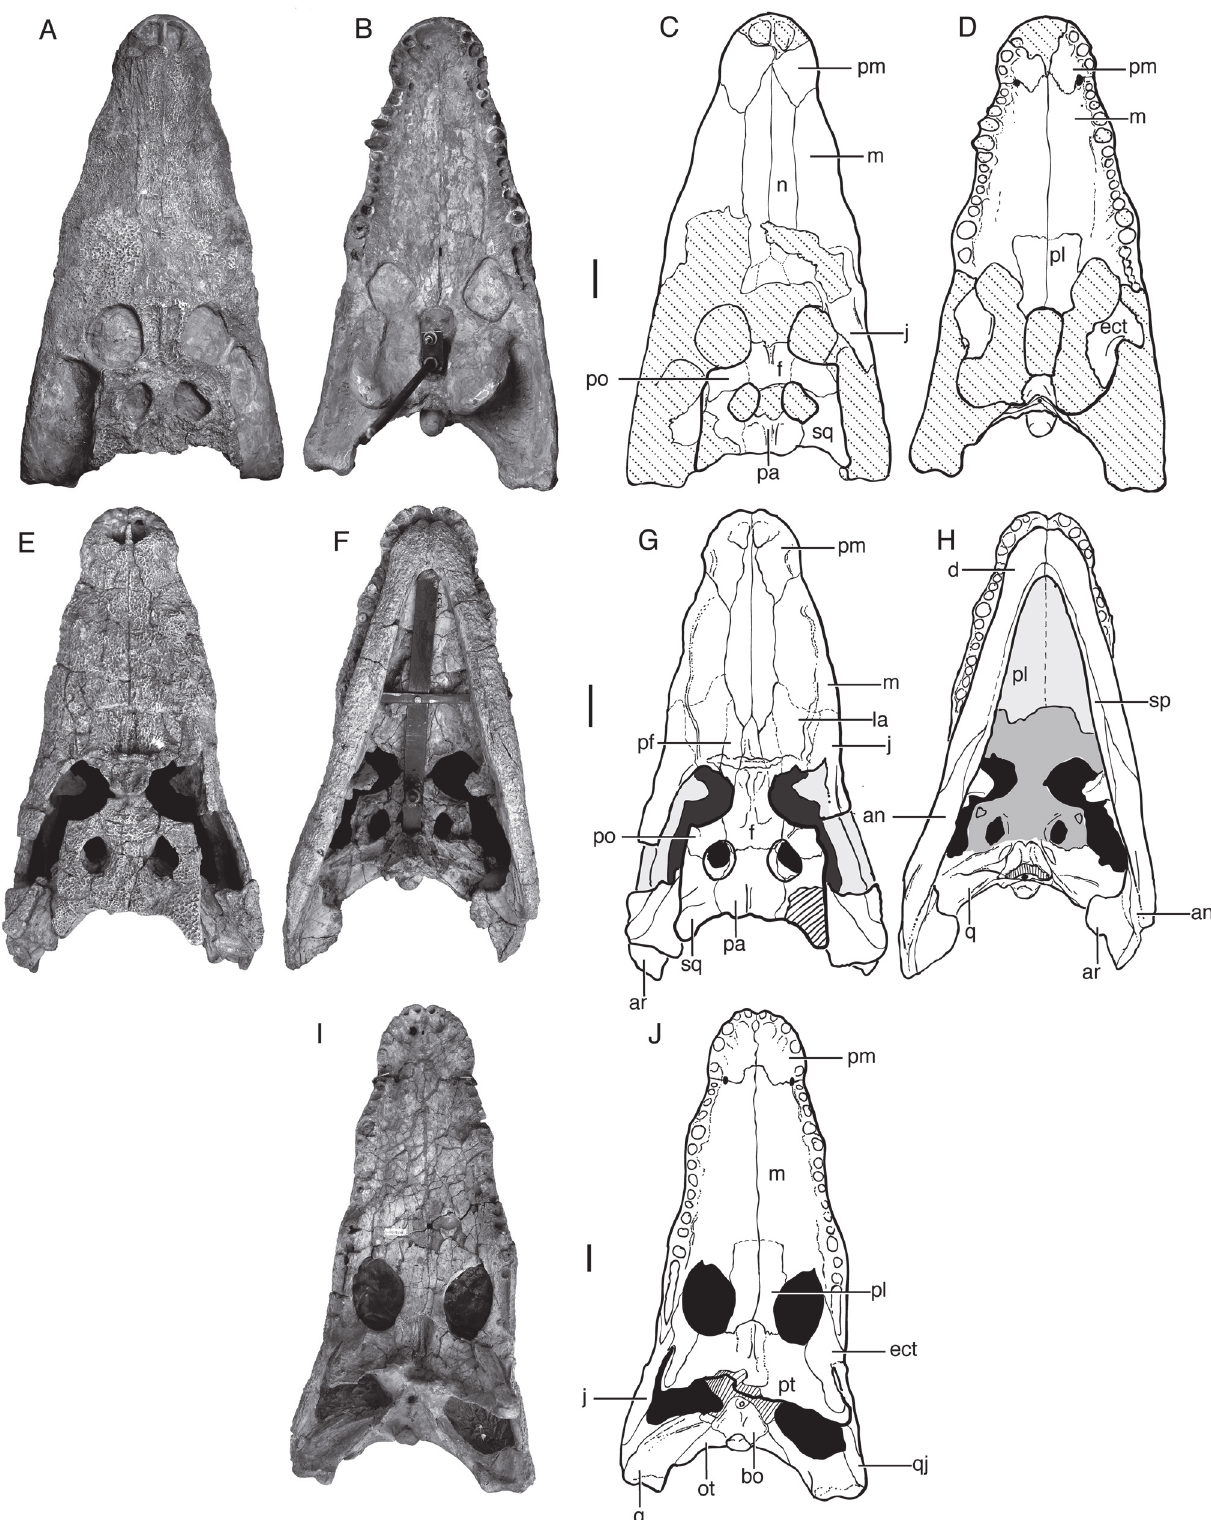
Fig 5. Paralligatorids from Bayanshiree Fm, Cenomanian to Santonian. A , Shamosuchus (= Paralligator ) major (PIN 3726/501, holotype), dorsal view; B , PIN 3726/501, ventral view; C , line drawing of PIN 3726/501, dorsal view; D , line drawing of PIN 3726/501, ventral view; E , Shamosuchus (= Paralligator